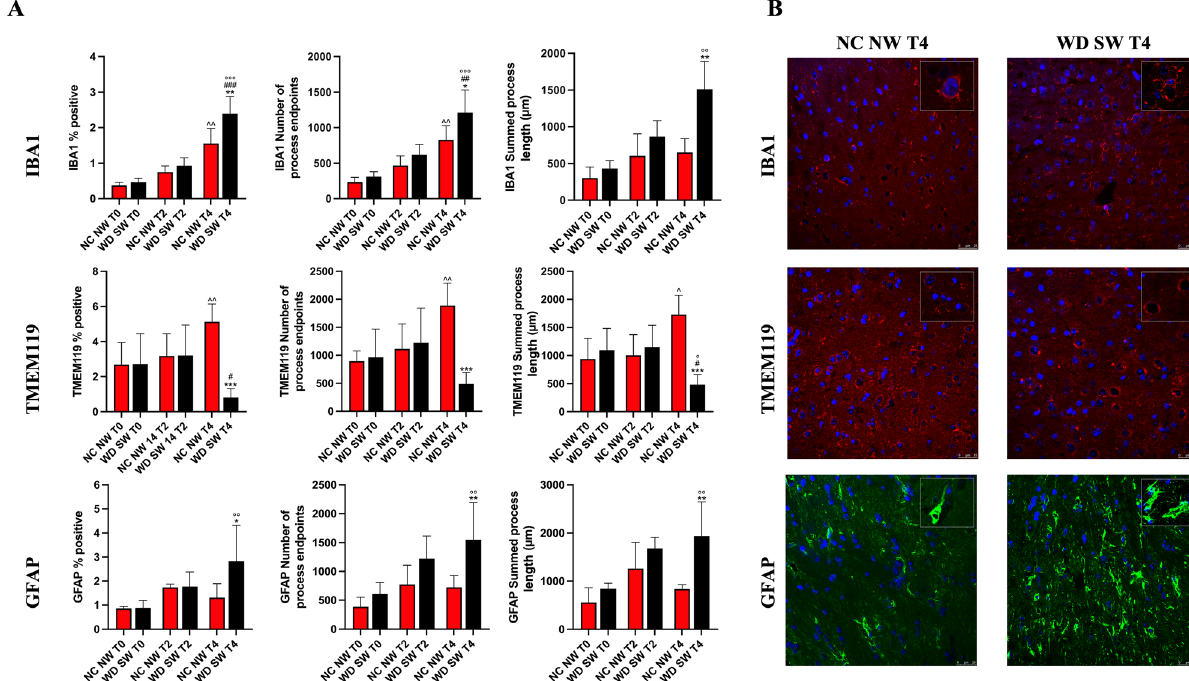
Figure 4. Immunofluorescence staining for IBA1 and TMEM119 in microglia and for GFAP in astrocytes. (A) The results are expressed as mean ± S.D. NC NW: Normal Chow Normal Water; WD SW: Western Diet Sugar Water. T0: 0 weeks; T2: 8 weeks; T4: 28 weeks. IBA1: Ionized calcium-binding adaptor molecule 1, TMEM119: Transmembrane protein 119, GFAP: Glial fibrillary acidic protein. *: p < 0.05, **: p < 0.01, ***: p < 0.001 vs NC NW T4; #: p < 0.05, ##: p < 0.01, ###: p < 0.001 vs WD SW T2, °: p < 0.05, °°: p < 0.01, °°°: p < 0.001 vs WD SW T0; ^: p < 0.05, ^^: p < 0.01 vs NC NW T0. (B) Representative confocal images of IBA1 positive microglia (above), TMEM119 positive microglia (middle), GFAP positive astrocytes (below) and magnified illustrations of microglia and astrocytes